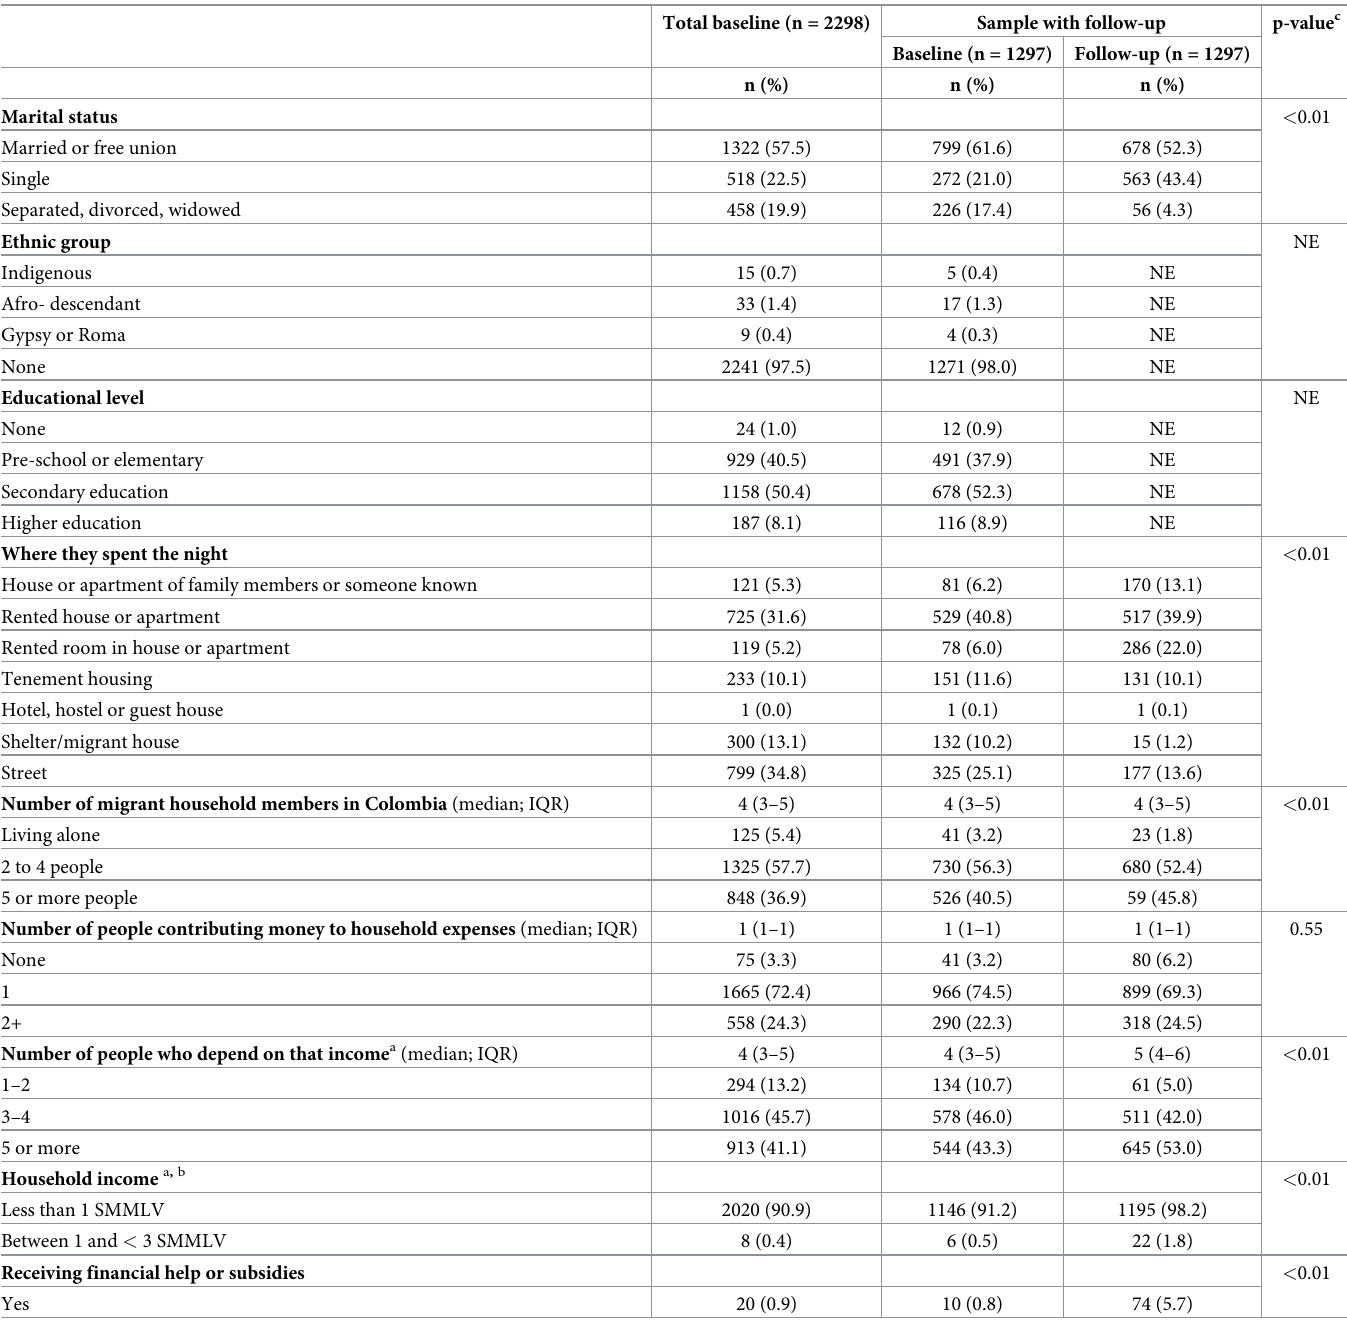
Table 1. Sociodemographic characteristics of the migrant women with irregular migration status participating in ELSA-VENCOL,